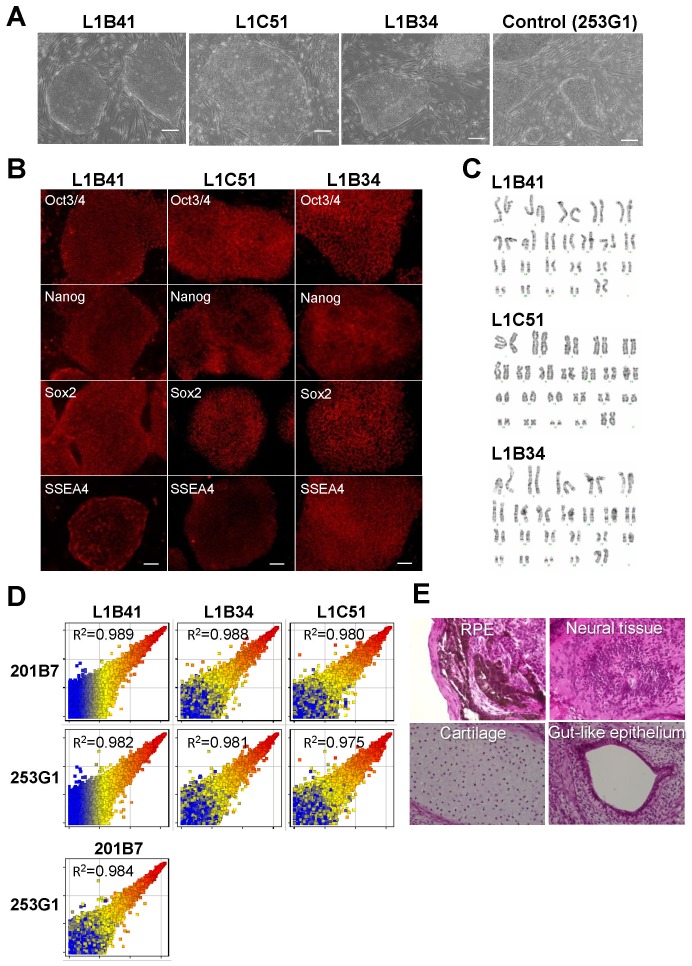
iPS cells were established from human corneal limbal epithelial cells (HLECs).(A) Three iPS-like cell colonies (L1B41, L1C51, and L1B34) were cloned after reprogramming of HLEC using Yamanaka 4 factors. (B) Immunofluorescent analysis showed that all 3 isolated iPS cell lines expressed the pluripotent stem-cell markers Nanog, Oct3/4, Sox2, and SSEA4. (C) Karyotype analysis showed no obvious aberration in the 3 iPS cell clones derived from HLEC. (D) Global expression analysis among iPS cells by microarray showed that the 3 HLEC-derived iPS cells exhibited similar expression to HDF-derived iPS cells. (E) HLEC-derived L1B41 was able to form a teratoma that contained the tissue originating from the 3 germ layers in the testis of SCID mice. Scale bar: (A) 200 µm, (B) 100 µm.